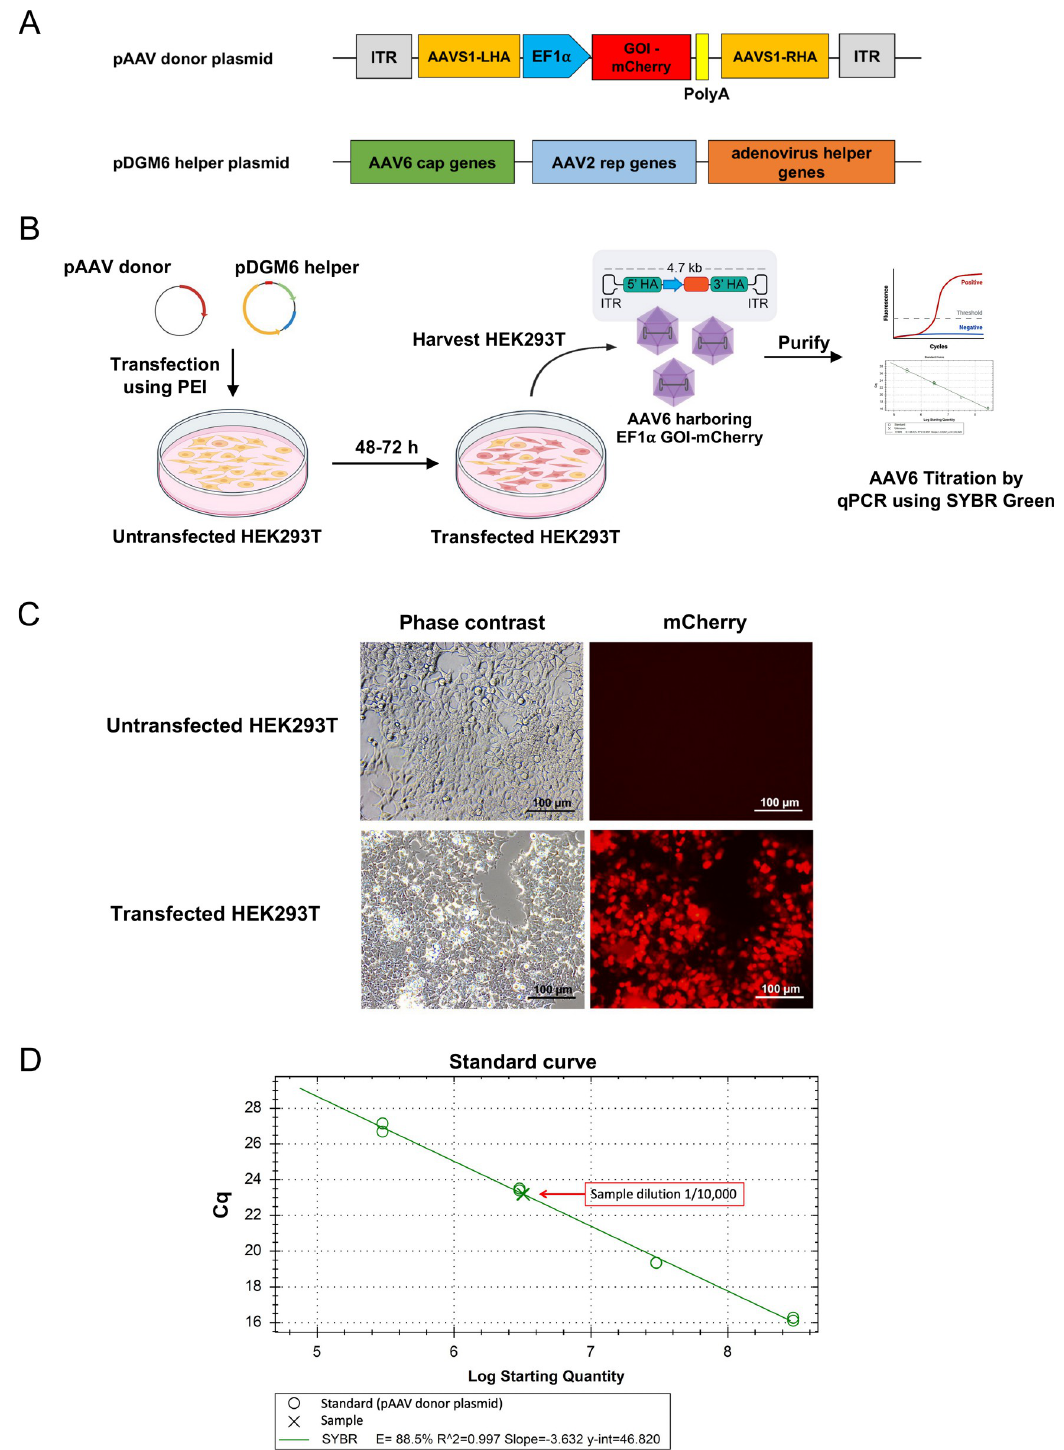
Fig 1. Production of AAV6 vectors in HEK293T cells. (A) The components of the pAAV donor plasmid and pDGM6 helper plasmid. The pAAV donor plasmid vector comprises ITR, left homology arm of AAVS1 gene (AAVS1-LHA), EF1 α promoter, the gene of interest (GOI) tagged with mCherry, polyA tail, right homology arm of AAVS1 gene (AAVS1-RHA) and ITR. The pDGM6 helper plasmid consists of the AAV6 cap genes, the AAV2 rep genes, and the adenovirus helper genes. (B) Schematic of AAV6 production by co-transfection of the pAAV donor and pDGM6 helper plasmid vectors into HEK293T cells. (C) Fluorescence microscopic analysis of the untransfected and transfected HEK293T cells at 3 days post-transfection. Scale bar = 100 μ m. (D) The qPCR standard curve was created by plotting the logarithmic DNA concentrations against Cq